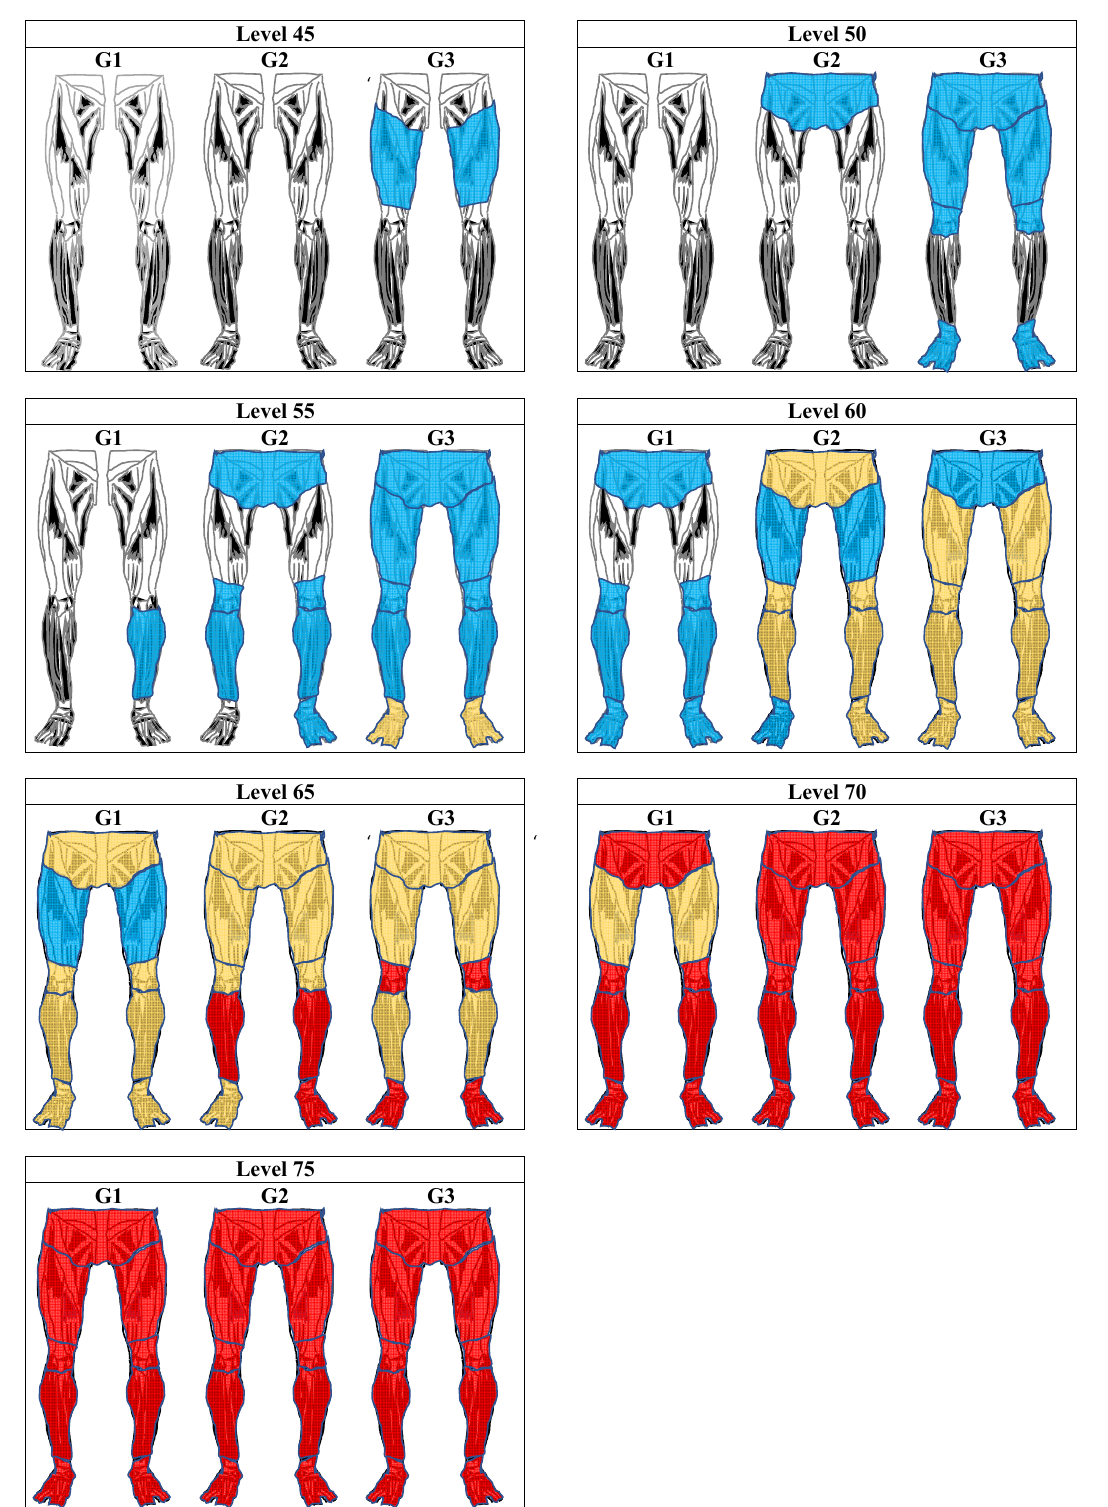
Figure 3. Evolution of lower limb musculoskeletal discomfort for the three groups at each scale level. Legend: blue, rarely feels pain; yellow, often feels pain; red, feels pain daily.